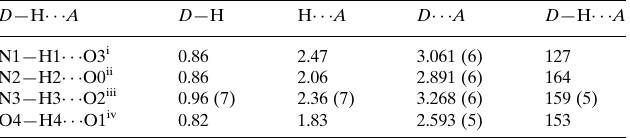
Hydrogen-bond geometry (A˚ , (cid:5)